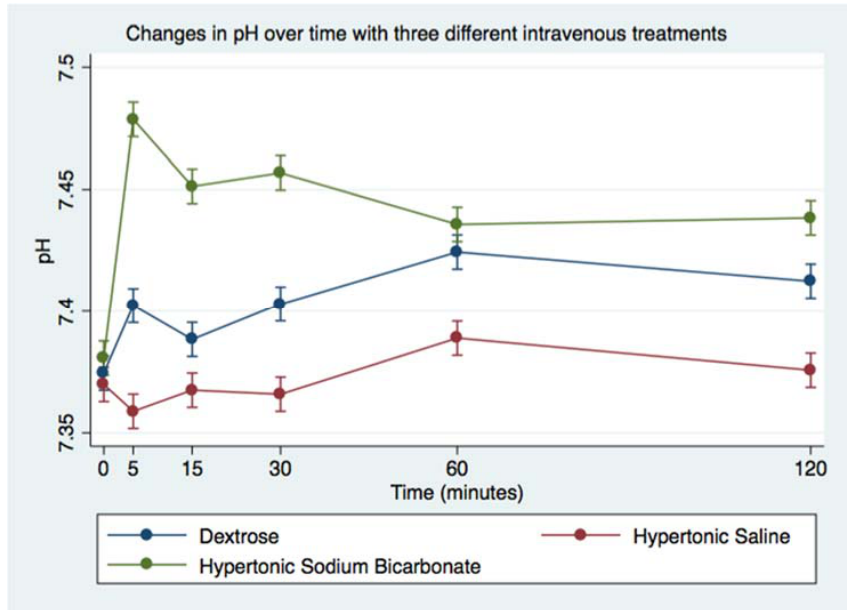
Figure 2. Overall effect of treatment on venous blood pH over time. The mean and SEM venous blood pH for all six horses. Blue = Treatment Group DS (5% dextrose solution at 2 mL/kg bwt); Green = Treatment Group HB (NaHCO 3 8.4% solution at 2 mmol/kg bwt); and Red = Treatment Group HS (NaCl 7.5% solution at 4 mL/kg bwt).